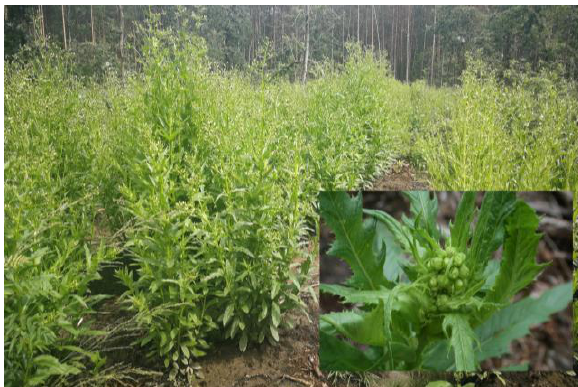
Fig. 5. Erechtites hieraciifolius (L.) Raf. ex DC. in Gomel Oblast of